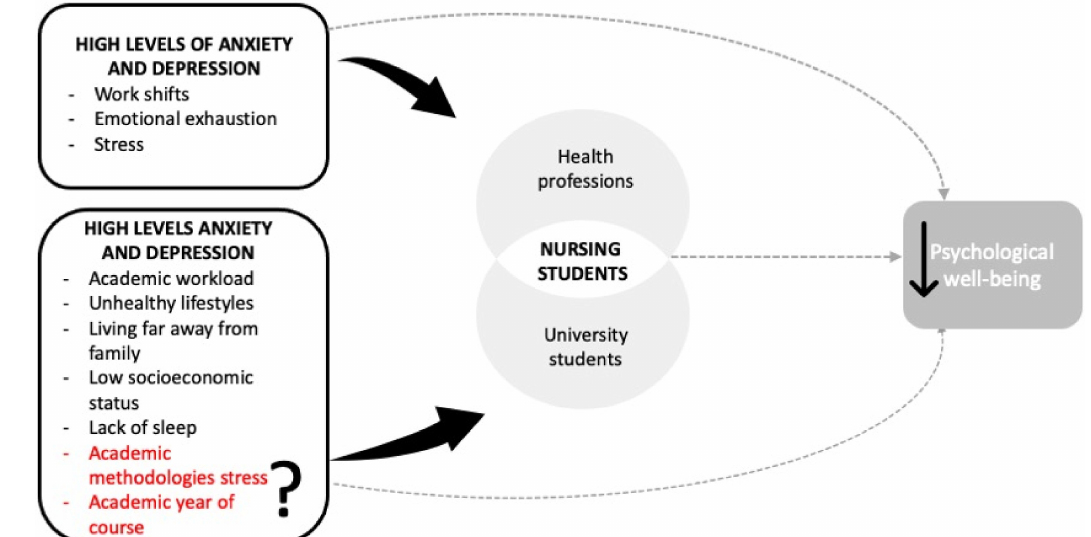
Figure 1. Conceptual framework of the study. On the left, in black, are the factors that have already been shown to directly affect mental health in both health professionals and college students. In red are the specific academic conditions that can affect psychological health depending on the academic year, but which remain